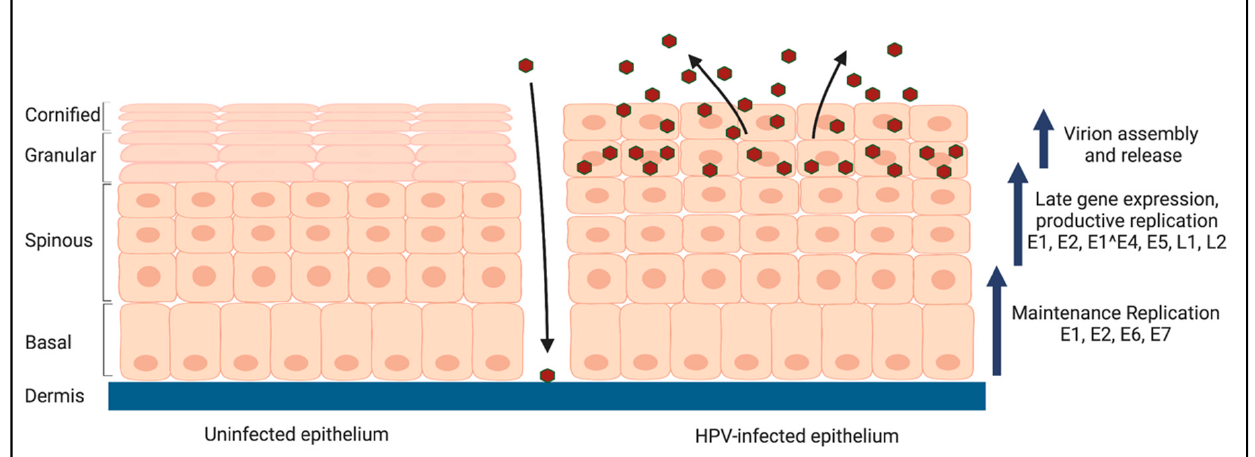
Figure 2. Overview of the HPV life cycle. HPVs infect the basal cells of the stratified epithelium through a microwound and transiently amplify to 50–100 copies per cell. Episomal copies are thought to be maintained at a low copy number in the undifferentiated, basal epithelial cells by replicating along with cellular DNA. Differentiation triggers the productive phase of the life cycle, resulting in high levels of late genes being expressed, including E1 and E2, that facilitate amplification of viral genomes to 100–1000 s of copies per cell. E1^E4 and E5 are also highly expressed upon differentiation and contribute to providing a replication-competent environment. E6 and E7 promote re-entry of differentiating cells back into the cell cycle to provide cellular factors required for viral replication. The expression of L1 and L2 results in the assembly of new virions that are released from the uppermost layers of the stratified epithelium. Created with BioRender.com (accessed on 10 August 2022).